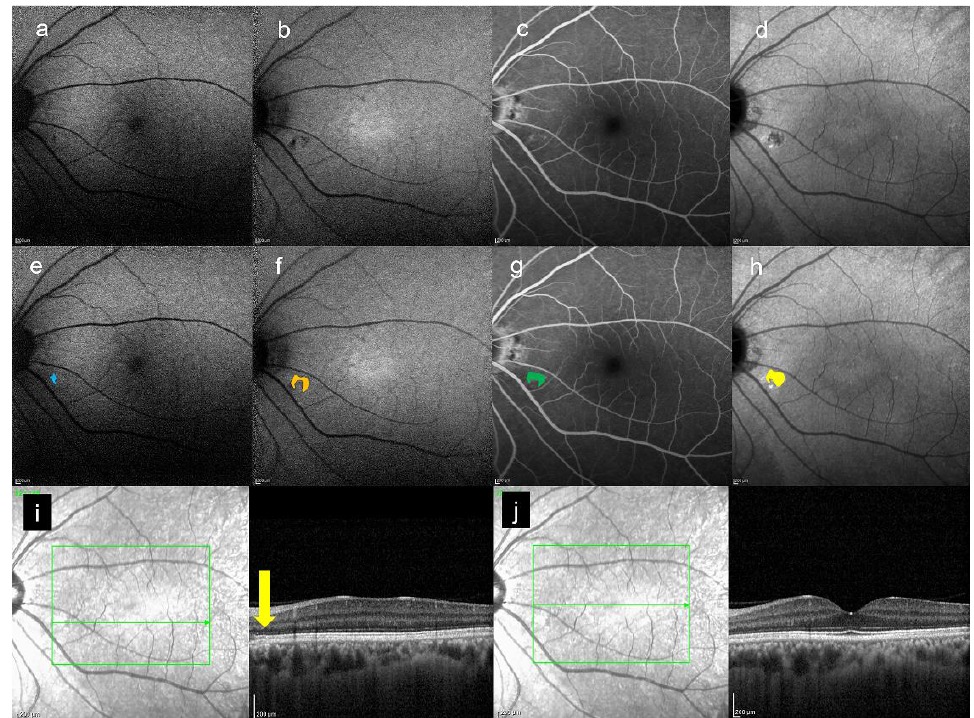
Figure 2. A 39-year-old man. All images are from the contralateral eye of CSC eye. ( a ) SW-FAF image, ( b ) NIR-AF image, ( c ) FA image acquired at 19 min, and ( d ) ICGA image acquired at 27 min. All images were acquired on the same day. ( e ) Abnormal foci which were colored in blue on ( a ), which are within the HFF area on ( d ). The area is 0.26 mm 2 . ( f ) Abnormal foci which were colored in orange on ( b ), which are within the HFF area on ( d ). The area is 0.51 mm 2 . ( g ) Abnormal foci which were colored in green on ( c ), which are within the HFF on ( d ). The area is 0.37 mm 2 . ( h ) The HFF which were colored in yellow on ( d ). The area is 0.51 mm 2 . ( i ) Infrared + OCT (horizontal section) through the abnormal foci (yellow arrow), ( j ) Infrared + OCT (horizontal section) through the fovea.